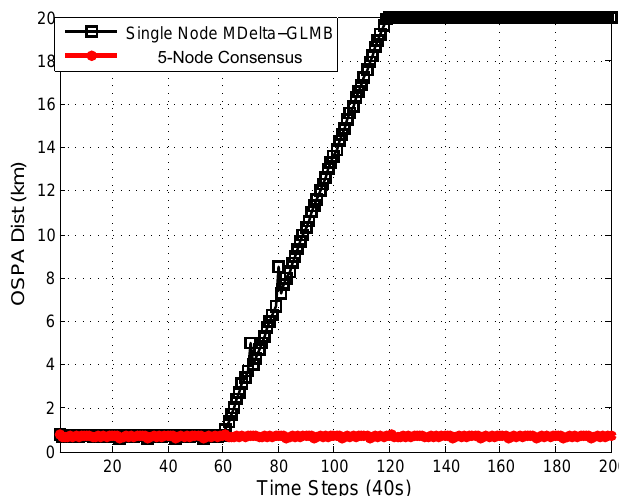
Figure 5. Estimation from single-node and 5-node consensus. Objects are starting to go outside the observation volume from the 60th time step and the performance for a single node becomes worse. Five-node consensus with complementary observation volumes provides accurate estimation for objects as long as they are in at least one node’s observation volume.